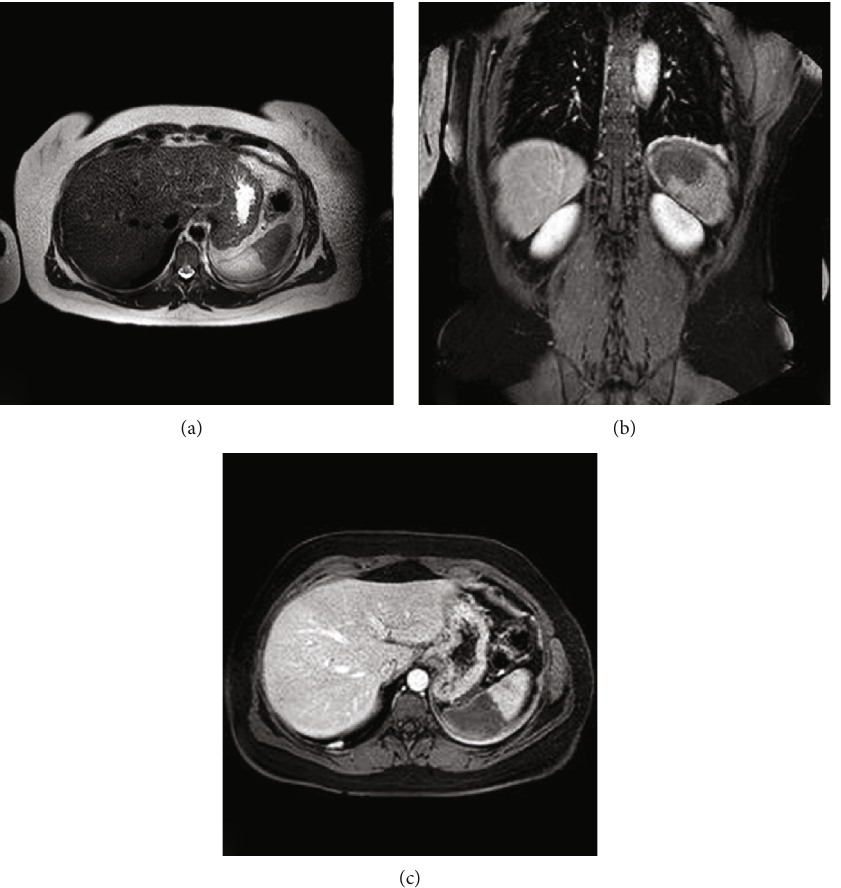
Figure 1: Abdominal MRI. Axial T2-weighted image (a) showing a high-intensity signal in the upper splenic portion. Coronal (b) and axial